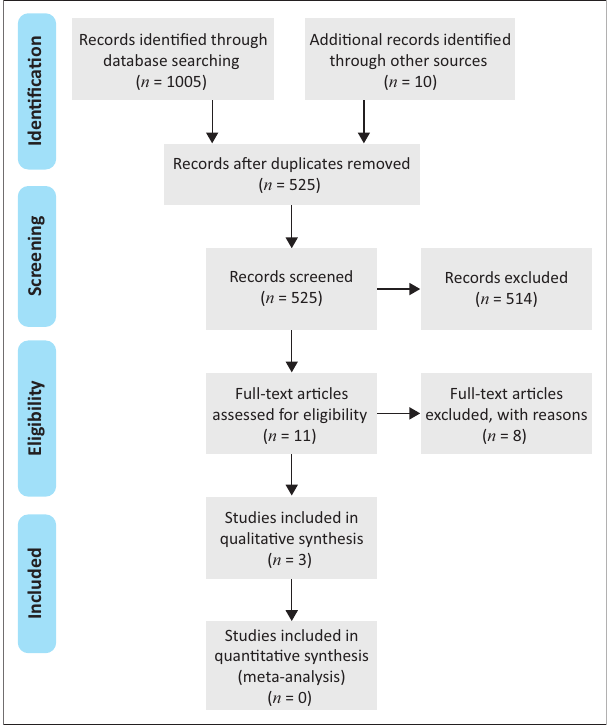
FIGURE 1 : Preferred Reporting Items for Systematic Reviews and Meta-Analysis flow